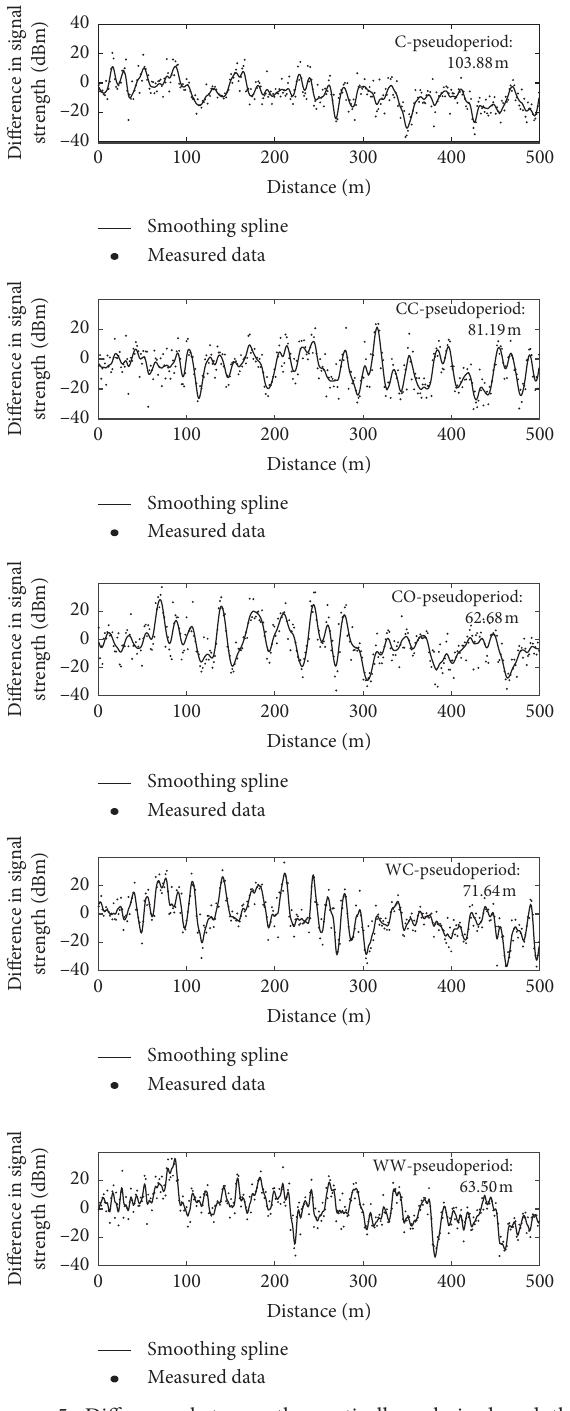
Figure 5: Difference between the vertically polarized and the horizontally polarized field power.